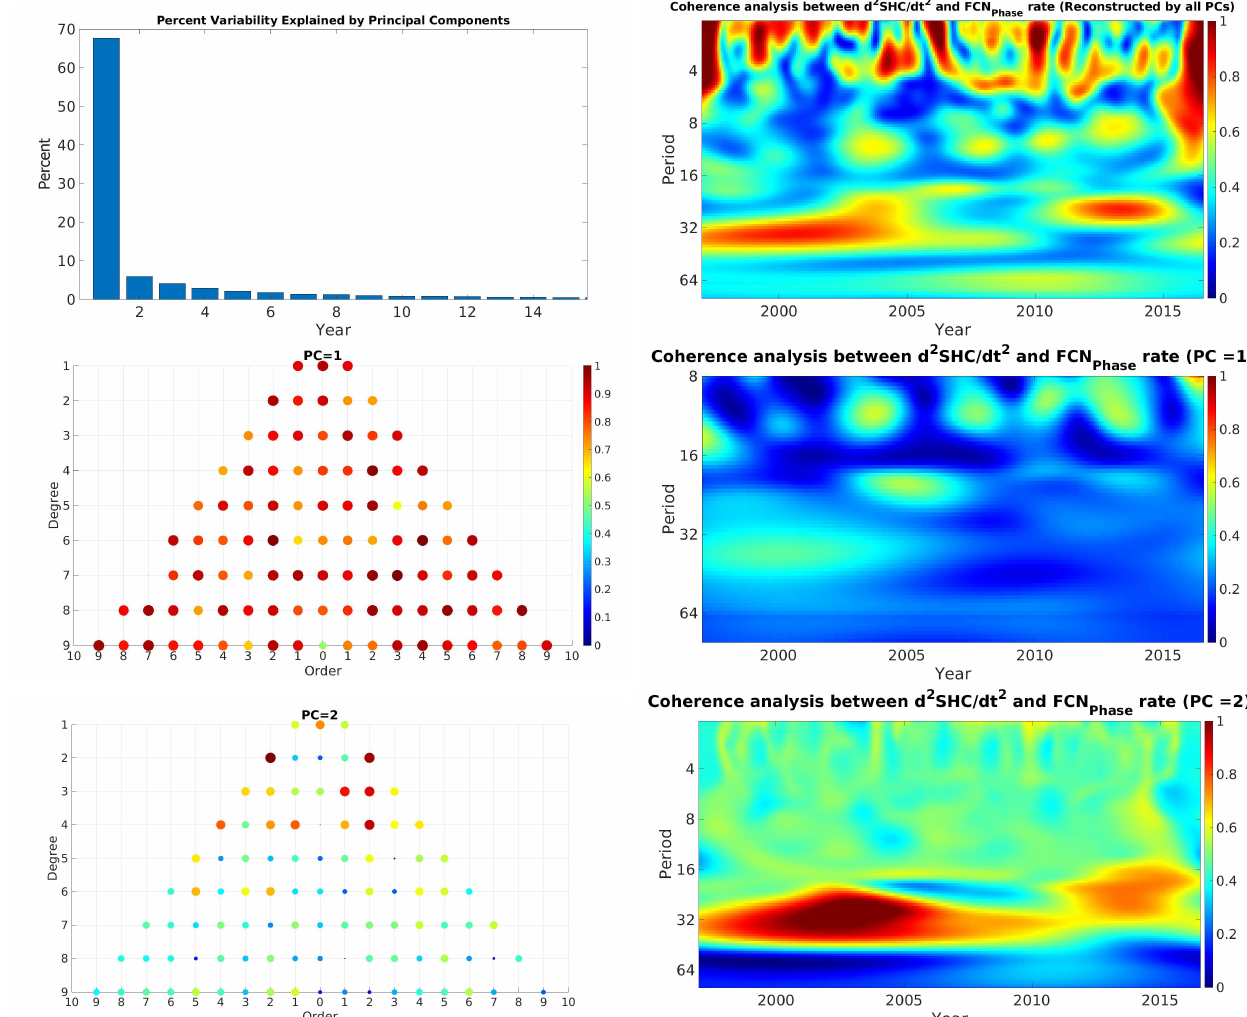
Figure 7. Wavelet coherence analysis between all SHC of GMF and FCN Phase rate (upper panel) and the percentage of each PC. Middle left panel: SHC correlation with the first PC. Middle right panel: the coherence between GMF and FCN Phase rate reconstructed by PC = 1. Lower left panel: SHC correlation with the PC = 2. Lower right panel: the coherence between GMF and FCN Phase rate reconstructed by PC = 2. Unit of periods is month.